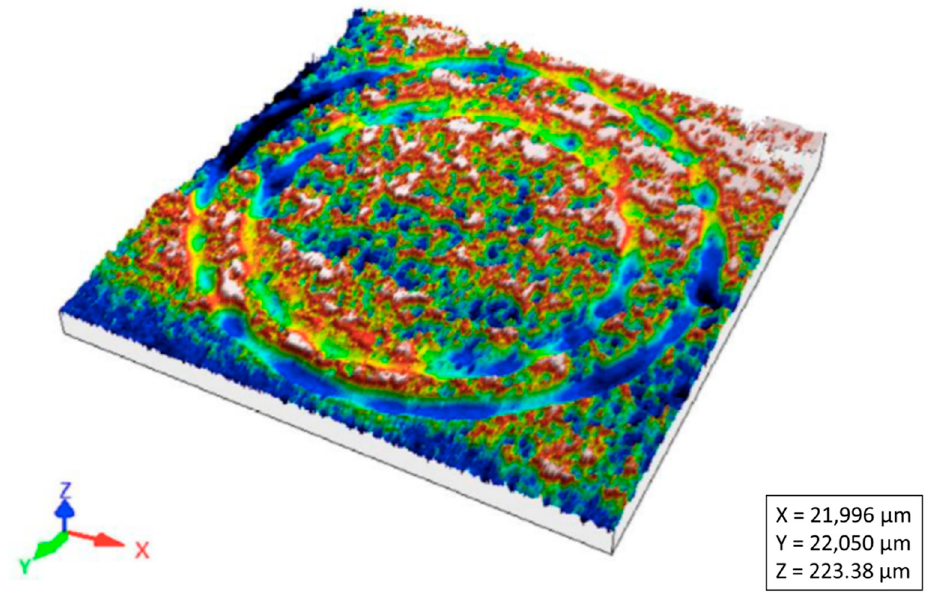
Figure 12. White light interferometer scan of wear scars on 13.3 vol% graphite coating. CoF and wear rate are summarized for each composition in Figure 13. Each data point is an average of three tests with the displayed error bars showing the standard deviation for each measurement.